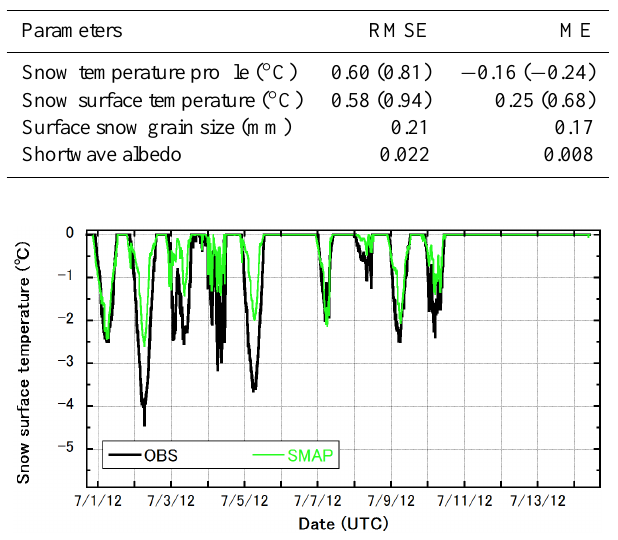
Figure 7. Snow surface temperature at the SIGMA-A site during the IOP observed with the AWS and simulated by the SMAP model. Observed snow surface temperature was calculated from observed downward and upward long-wave radiant fluxes (Sect.